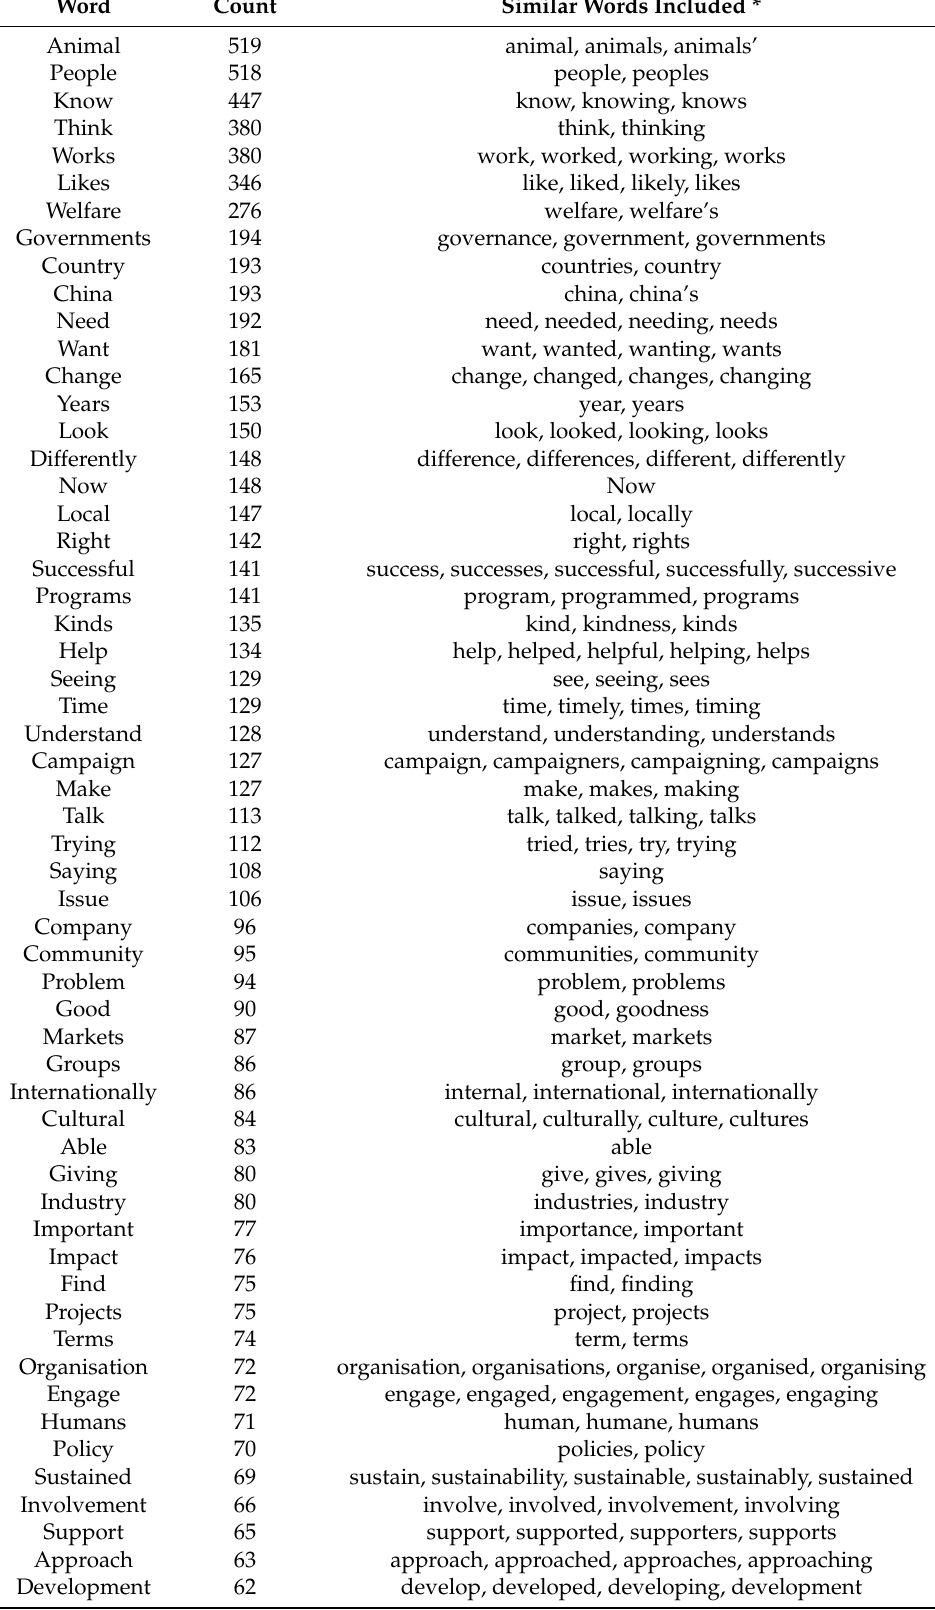
Table 1. Frequency of words associated with successful